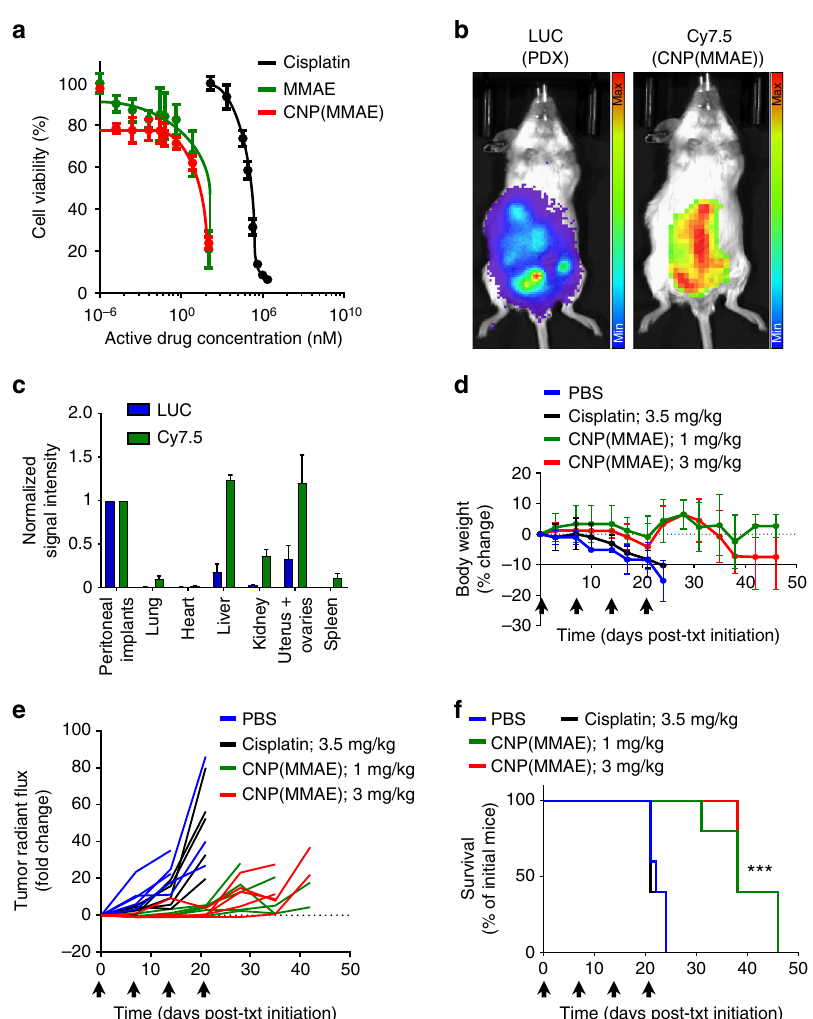
Fig. 6 Therapeutic activity of MMAE-conjugated nanoparticles against platinum-resistant and high-grade serous ovarian cancer (HGSOC). a Primary HGSOC cells were cultured and treated with either cisplatin, free MMAE, or coated and MMAE-conjugated nanoparticles (CNP(MMAE)) for 72h prior to cellular viability measurements by the colorimetric CCK8 assay; the results were compared to those obtained from untreated cells. b Representative in vivo images of a single C.B-17/Icr-SCID/Sed mouse implanted with LUC + primary HGSOC cells (LUC + PDX model) at 72h after IP administration of coated, Cy7.5-labeled, and MMAE-conjugated nanoparticles (CNP(MMAE/Cy7.5)). c Quanti fi cation of the relative ex vivo signal intensities in each organ at the time of animal sacri fi ce ( n = 3 identically processed mice). The signal intensity from each reporter channel was normalized to the value measured from the intestines of each animal, which had high burdens of micrometastatic tumor foci. d Changes in the body weights as compared to baseline. e A plot of tumor burden over time as determined by changes from the baseline radiant fl ux associated with the BLI signal intensity. f Survival of LUC + PDX-bearing mice that received ×4 weekly IP injections of CNP(MMAE) (at an equivalent dose of either 1 or 3mg/kg MMAE), free cisplatin (at 3.5mg/kg platinum), or PBS (control treatment); note that the black arrows indicate the timing of each dose of treatment. Mice that were administered CNP(MMAE) at either 1- or 3-mg/kg dose equivalent of free MMAE demonstrated signi fi cant improvements in survival as compared to mice treated with PBS or cisplatin (*** p -value < 0.001, Log-rank